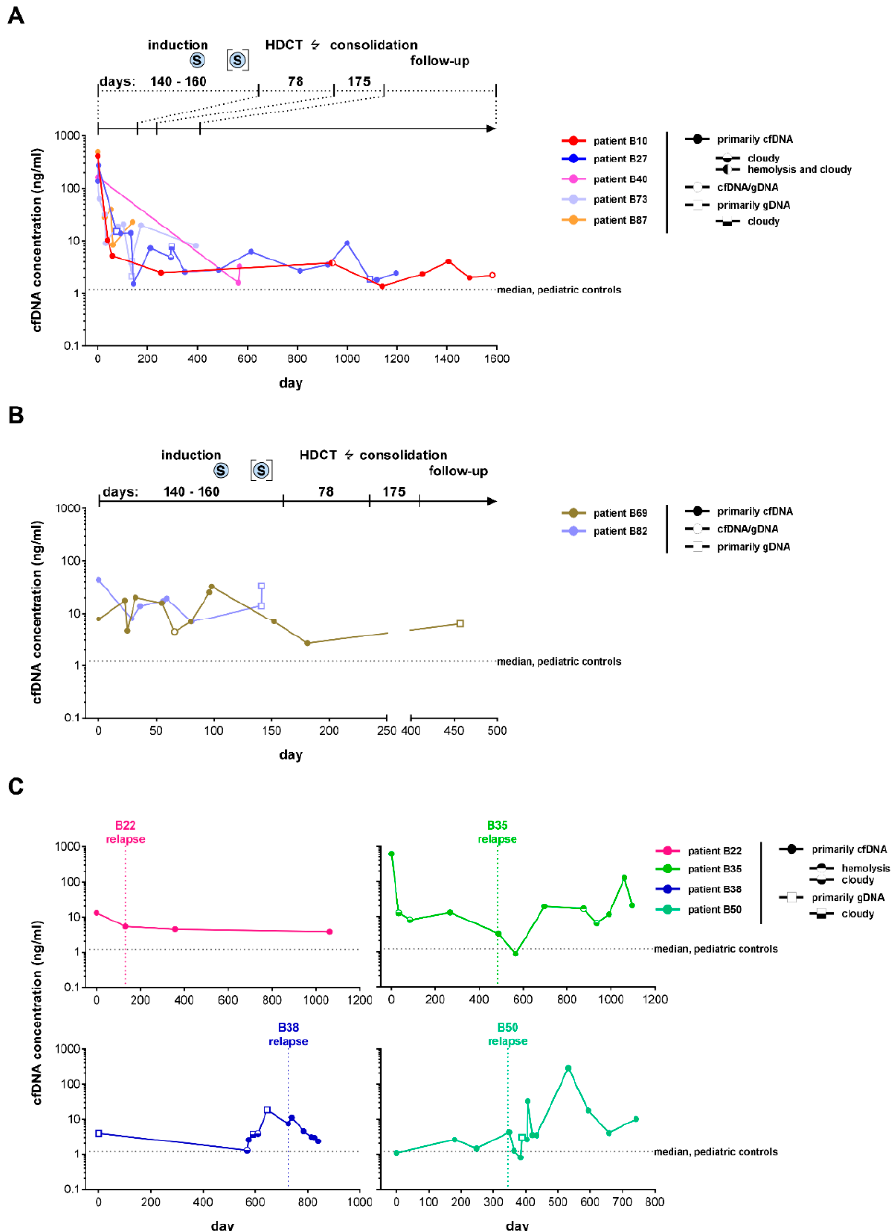
Figure 5. Longitudinal monitoring of cfDNA concentration in blood plasma from patients with high-risk neuroblastoma demonstrates highly variable baseline cfDNA concentrations and rapid cfDNA clearance following favorable treatment response. Total blood-based cfDNA concentrations from patients with a high cfDNA baseline concentration (>50 ng/mL plasma) are summarized in ( A ) while those from patients with a low baseline cfDNA concentration ( ≤ 50 ng/mL) are shown in ( B ). Retrospective cfDNA quantification in sequentially collected blood samples from patients with relapsed high-risk neuroblastoma is shown in ( C ). Total cfDNA concentrations were quantified using the Agilent 4200 TapeStation System. Dashed lines indicate the median cfDNA concentration in the pediatric control cohort. The treatment modules according to the German NB2004 Trial (EudraCT 20661) and the consecutive 2017 Guidelines for Diagnosis and Treatment of Patients with Neuroblastic Tumors are indicated above the plots. HDCT, high-dose chemotherapy; , radiation; S, sur- gery.